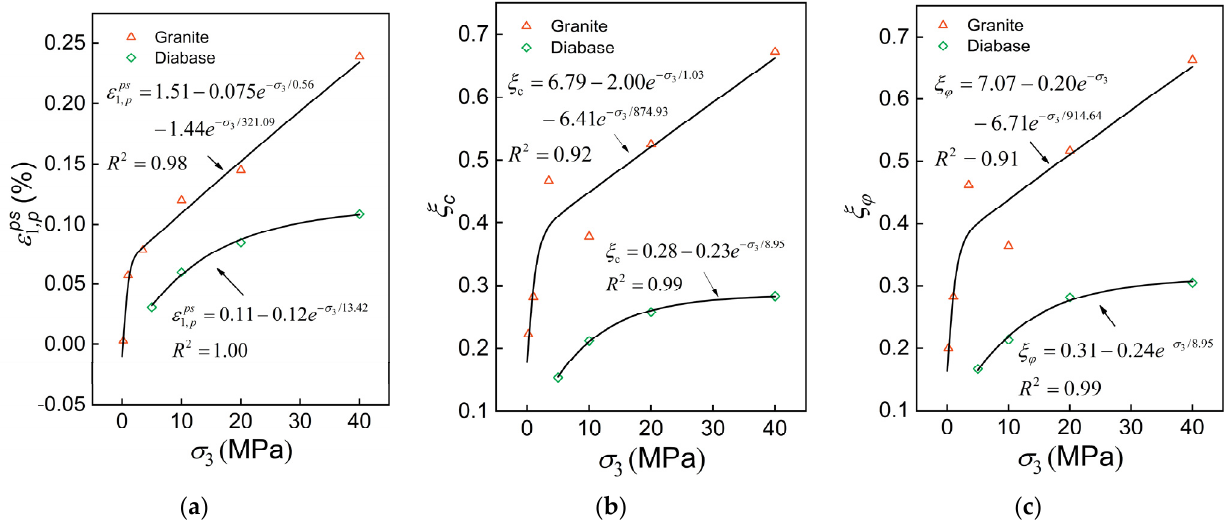
Figure 6. Fitting curves of parameters for two hard brittle rocks at different confining pressures: ( a ) , ( b ) ξ c , ( c ) ξ φ . ε ps 1 ,p